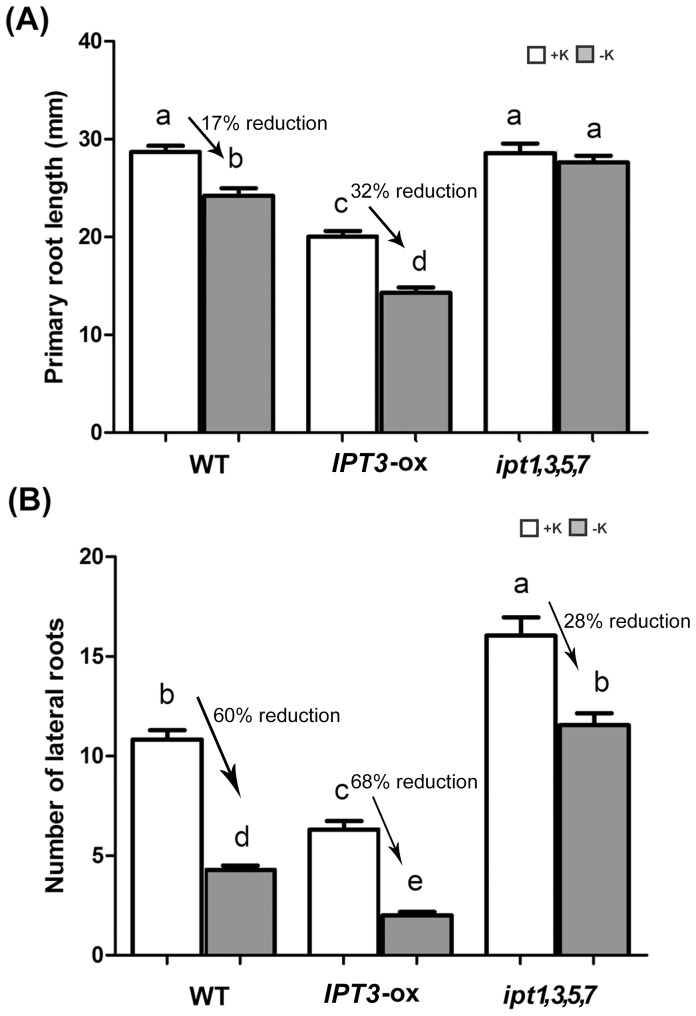
Root growth assay of Arabidopsis WT, IPT3-ox and ipt1,3,5,7 plants under +K and -K conditions.Plants were grown under +K conditions for 4 days and then transferred and grown on +K or −K medium for 7 days. Length of primary root (A) and number of lateral roots (B) were analyzed (n>30). Different letters indicate significant differences from each other as determined using ANOVA(P<0.05) and significances were corrected post hoc using Tukey’s HSD comparisons.